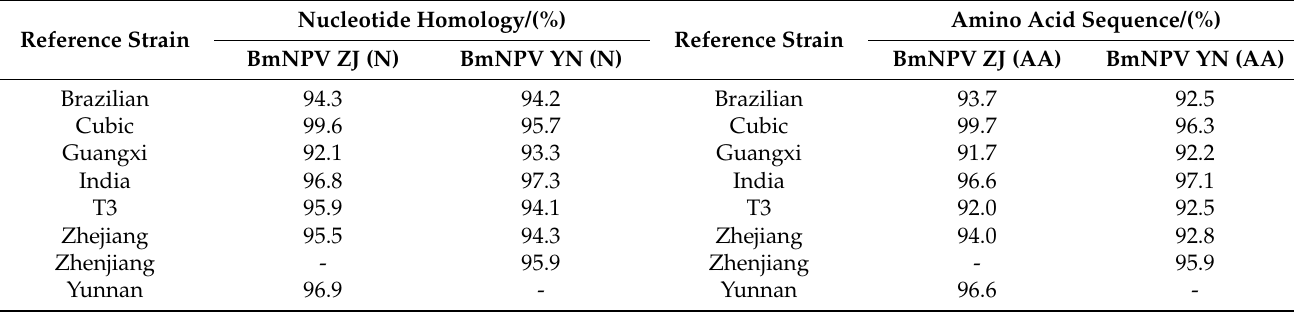
Table 5. Nucleotide and amino acid homology of bro-d gene